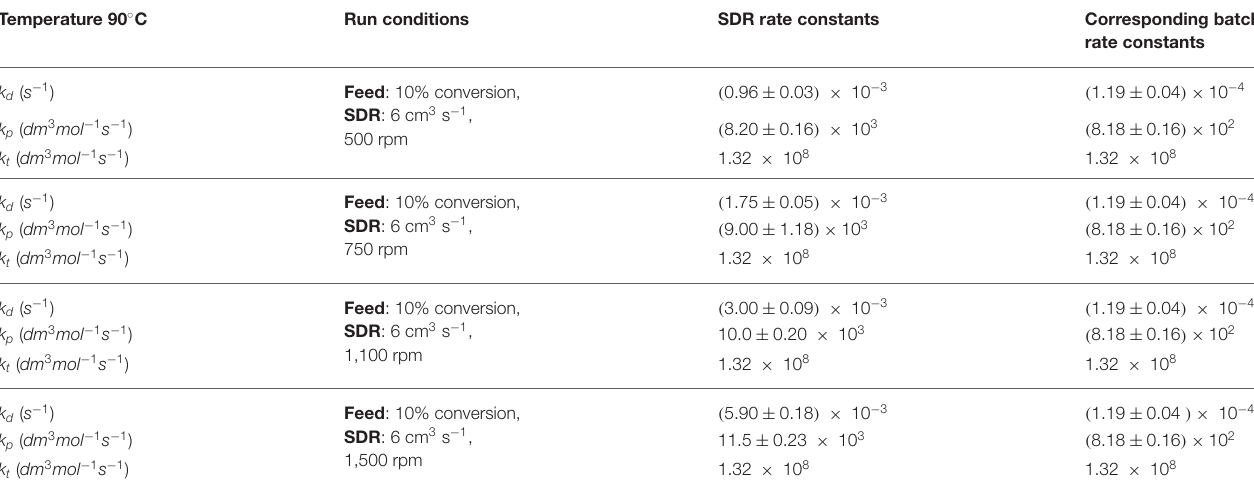
TABLE 3 | Polymerization rate constants k d , k p , and k t at 90 ◦ C in SDR and batch reactor.